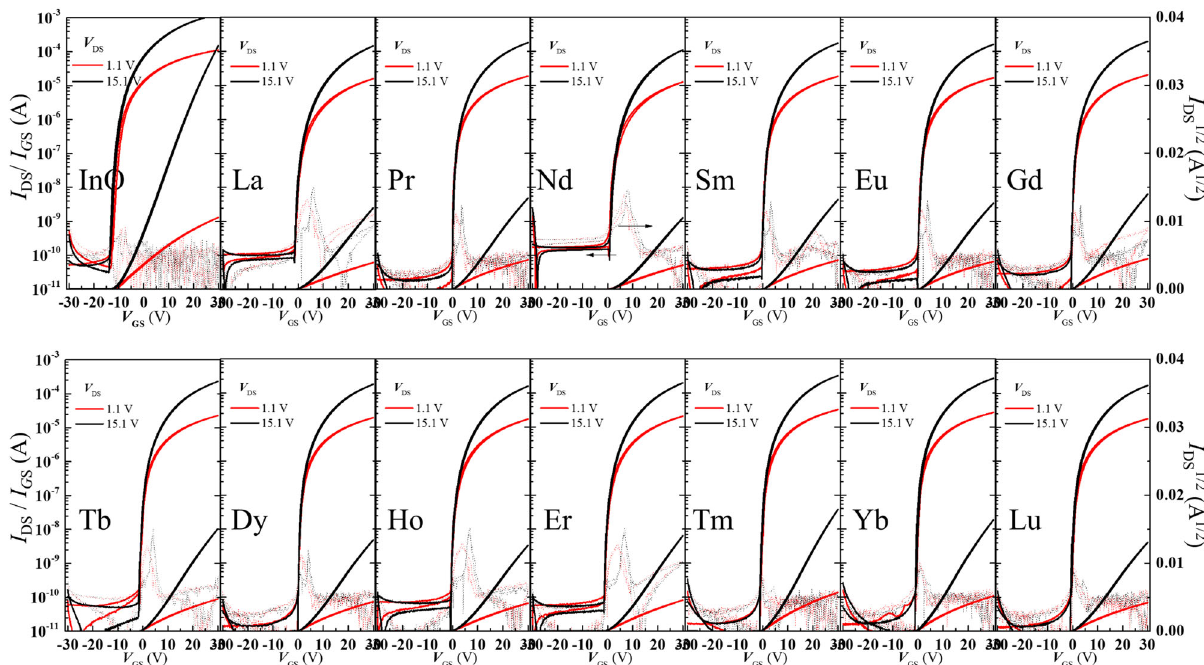
Fig. 4 Transfer characteristics of Ln:In 2 O 3 TFTs. Transfer characteristics of TFTs based on spin-coating Ln:In 2 O 3 aqueous precursor solutions with annealing at 300 °C in air condition, the V DS was held at 1.1 V (red curve) and 15.1 V (black curve), respectively, and the V GS sweep from − 30 to 30